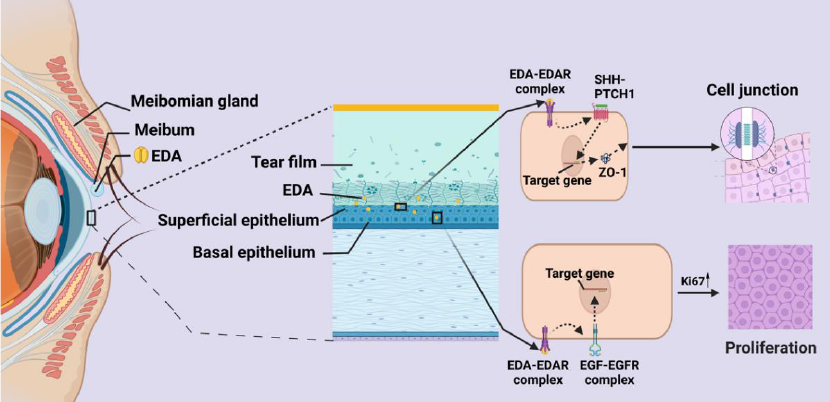
Figure 2. The expression of EDA-EDAR in the ocular surface [33]. ( A ) Immunofluorescent staining of EDA and EDAR expression in the corneal (Cor) and conjunctival (Conj) epithelium, lacrimal gland (LG) and meibomian gland (MG). (Scale bars represent 50  m). ( B ) Western blot results of EDA and EDAR in corneal epithelium, conjunctiva, lacrimal gland and meibomian gland tissues.